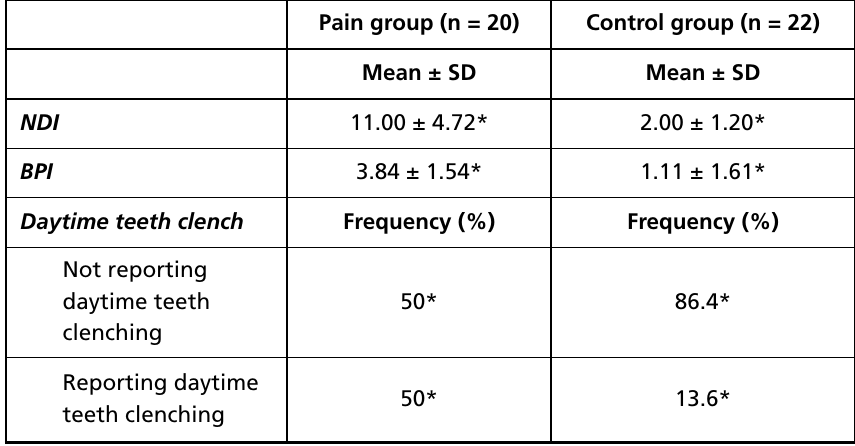
table 4: cervical disability (nDi), pain (BPi) and prevalence of teeth clenching